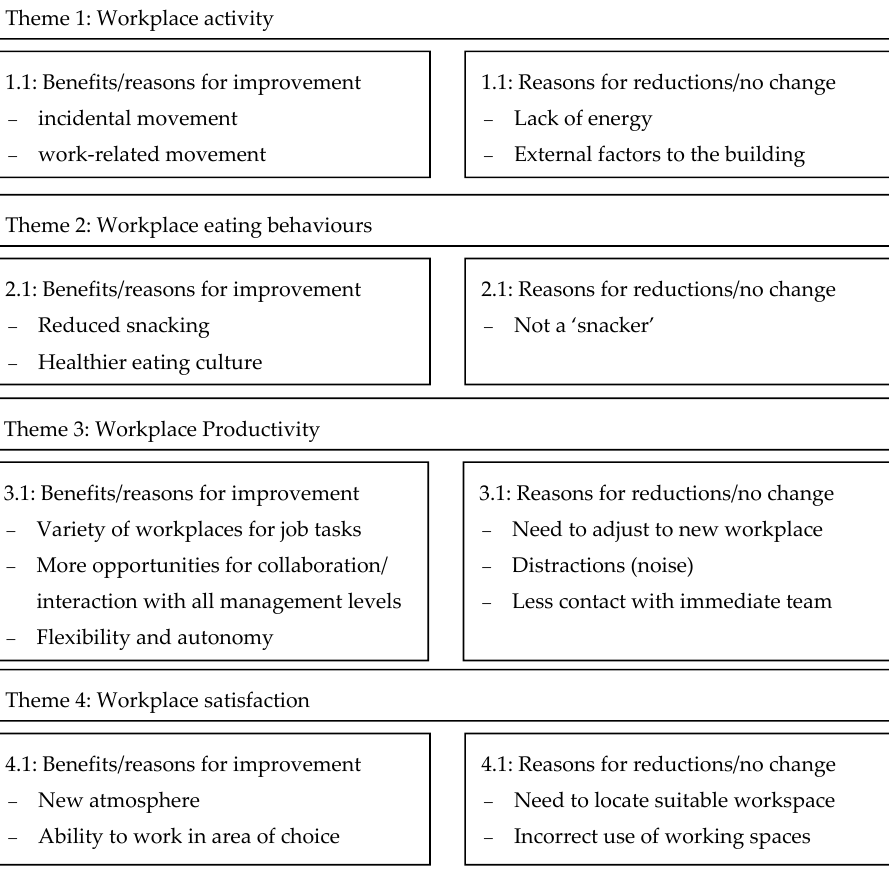
Figure 2. Themes and sub-themes constructed from the qualitative data.